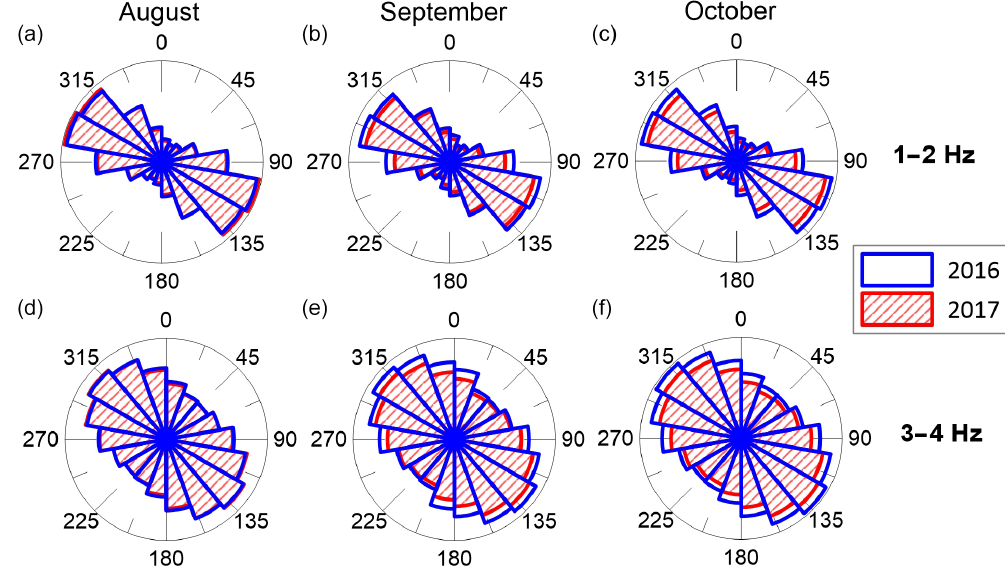
Figure 7. Monthly azimuthal distribution of the seismic noise in the time interval August–October 2016 (blue rose plot) and 2017 (red rose plot) obtained at IOCA station in the 1–2Hz (a–c) and 3–4Hz (d–f) frequency